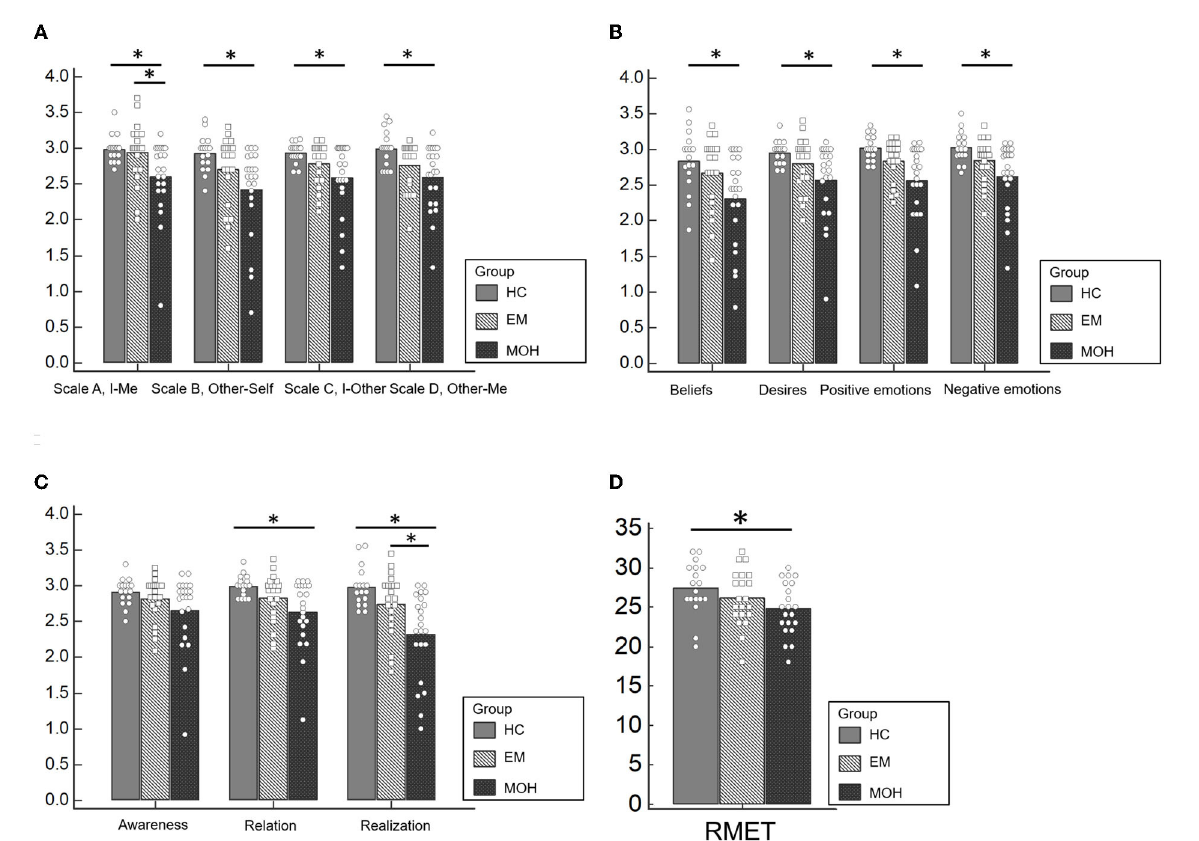
FIGURE1 Performances of HC, EM, and MOH groups in ToM battery. (A) Represents the results of the ThoMAS in the separate scales. (B) Displays the results of the single dimensions of the ThOMAS. (C) Shows the results of the subscales of the ThOMAS. (D) Displays the results of the RMET. Statistical significant results are marked with * .